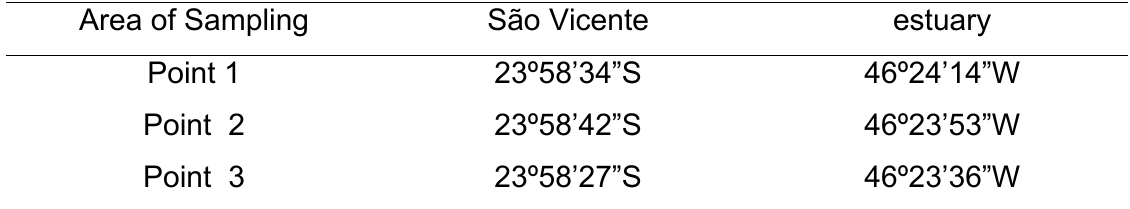
Table 1. Characterization of the sampling points in São Vicente’s estuarine system, São Paulo State,